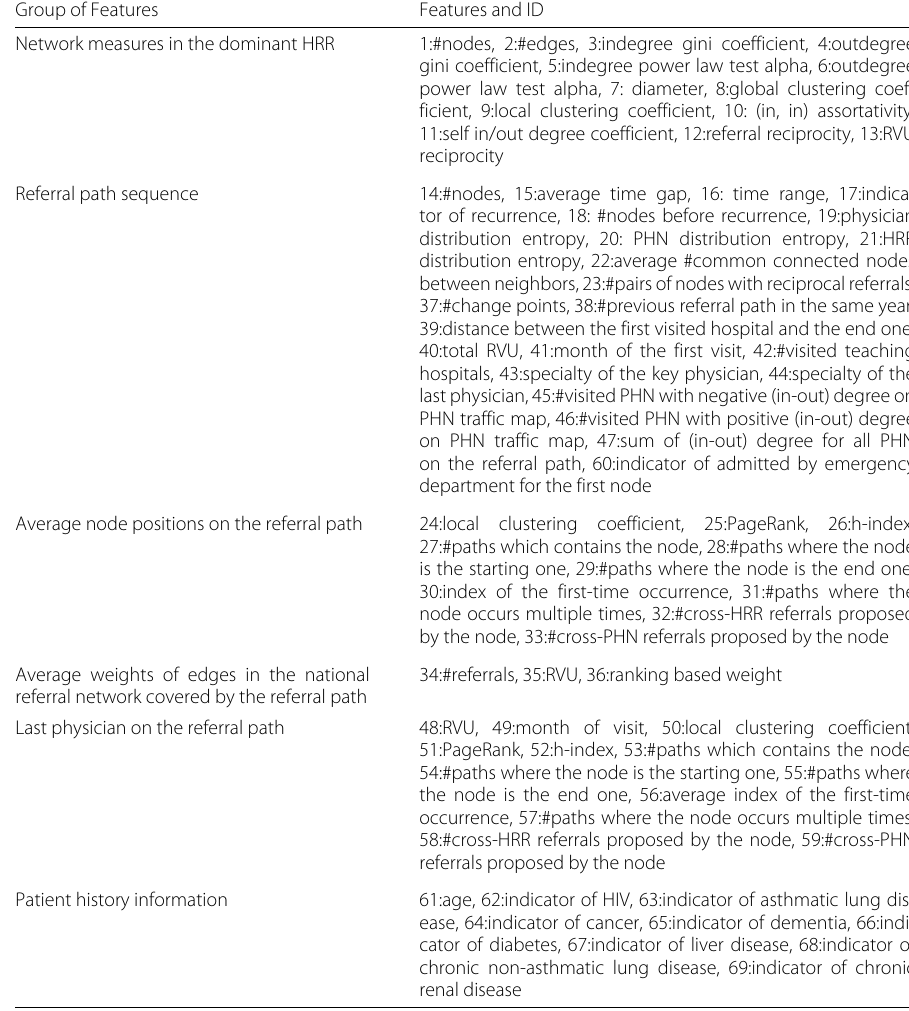
Table 11 Feature list of a referral path for treatment outcome classification/regression Group of Features Features and